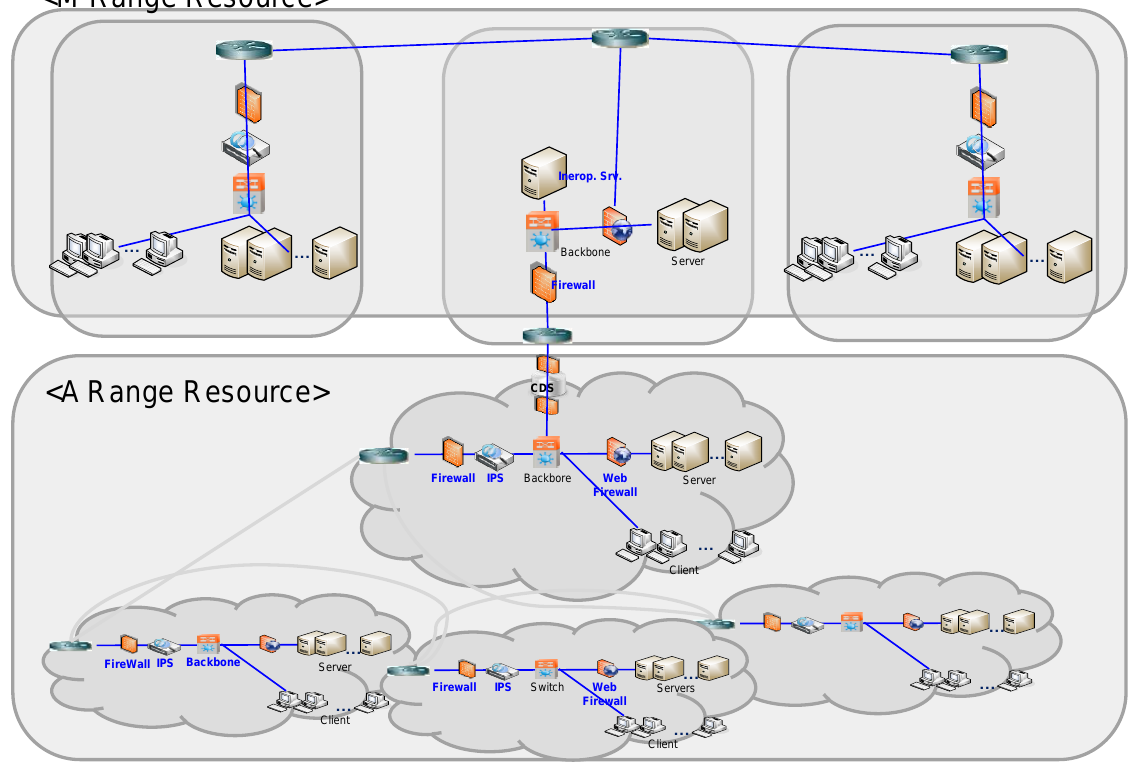
Figure 12. Multi-range configuration example (Joint Staff C4I 3, Army C4I 4 SITE).